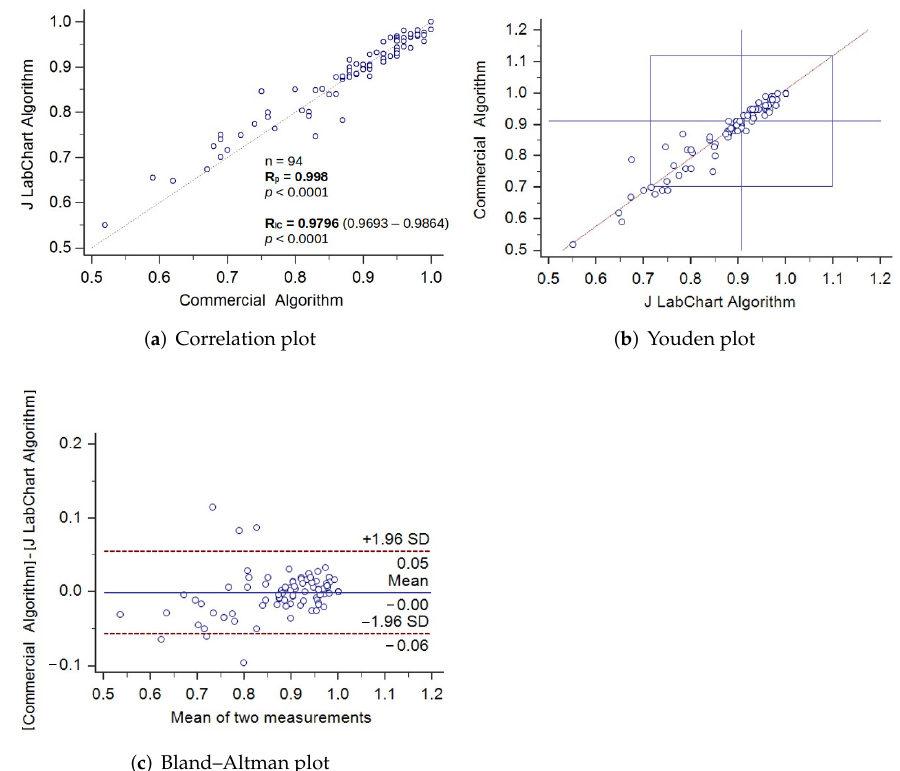
Figure 11. Statistical analysis results for the iFR index between commercial software and